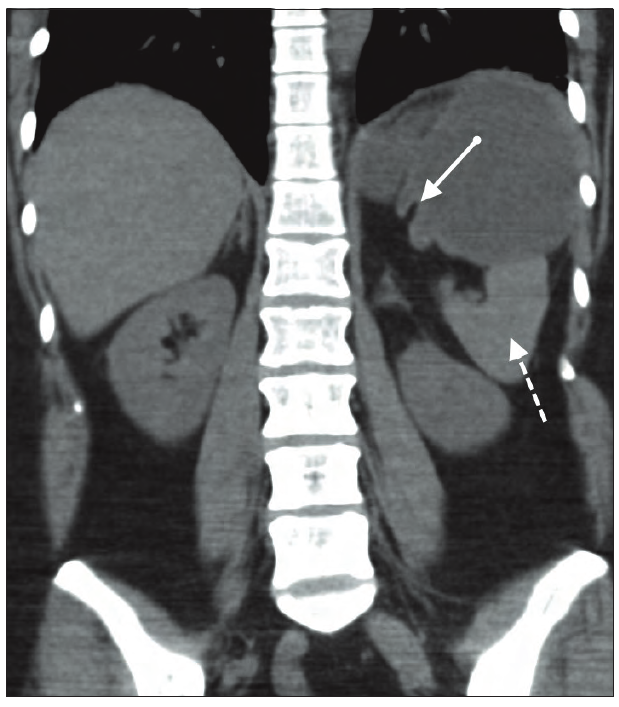
Fig. 3. Coronal CT image showing abnormal gastric fold (solid arrow). The inferiorly displaced ‘wandering spleen’ is also seen (broken arrow).